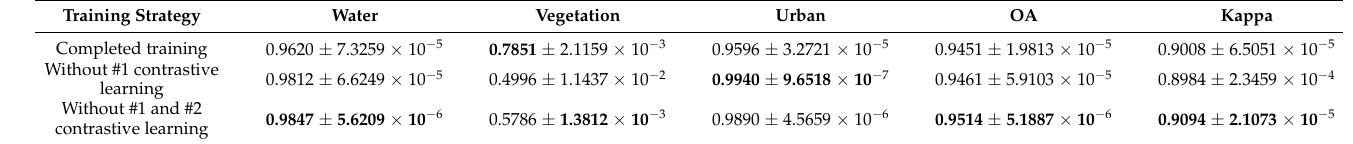
Figure 14. Effect of gradually training for our model. The left column is the classification results based on the completed gradually training; the middle column is the classification results without self-supervised contrastive learning; the right column is the classification results with the model removing the two stages of contrastive learning. Table 7. Classification Results of San Francisco by using different training strategies, where the highest mean and lowest variance for each category are marked in bold.